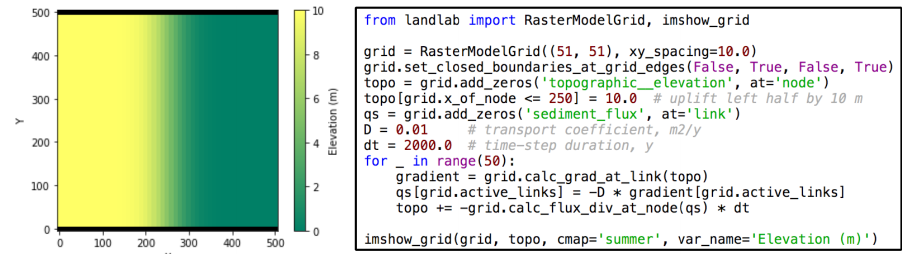
Figure 10. Example of a simple finite-volume numerical model of hillslope evolution, written in Python using the Landlab library. The model uses a diffusion equation to represent an evolving hillslope. The concise source code at right illustrates the use of a Landlab grid object together with fields and built-in functions for numerical gradient and divergence functions on these fields.